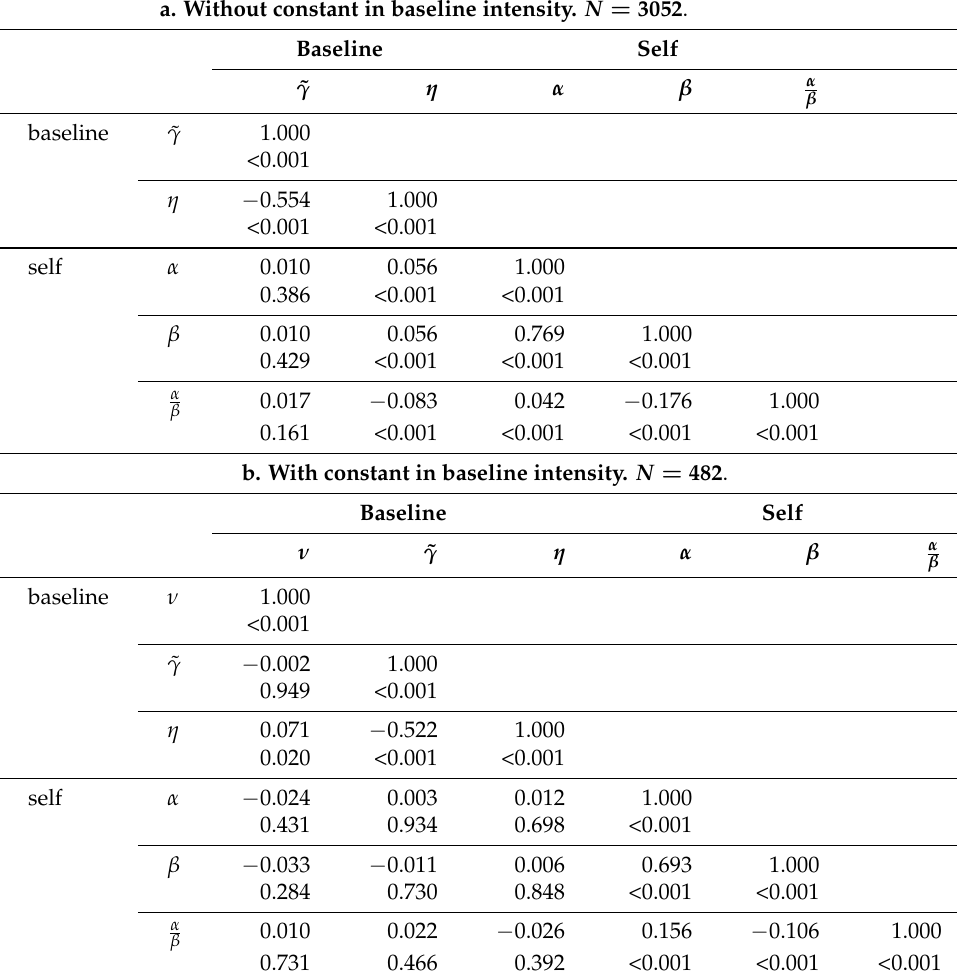
Table 6. Kendall’s taus and associated p -values for pairs of parameters of the models with self- excitation. a. Without constant in baseline intensity. N = 3052